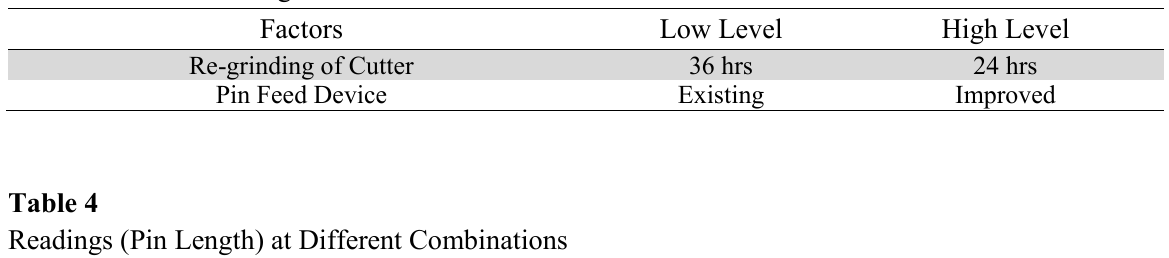
Readings (Pin Length) at Different Combinations